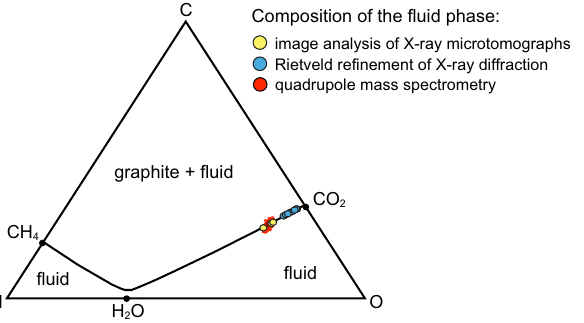
Figure 4. Fluid composition estimates (in wt%) plotted on a ternary C–O–H phase diagram (calculated at 1 GPa and 800 °C). The results of Rietveld refinement of single X-ray z-scans (blue dots) and image analysis (yellow dots) are compared with the reference fluid composition measured by QMS (red cloud). The black thick line represents all the possible compositions of graphite-saturated C–O–H